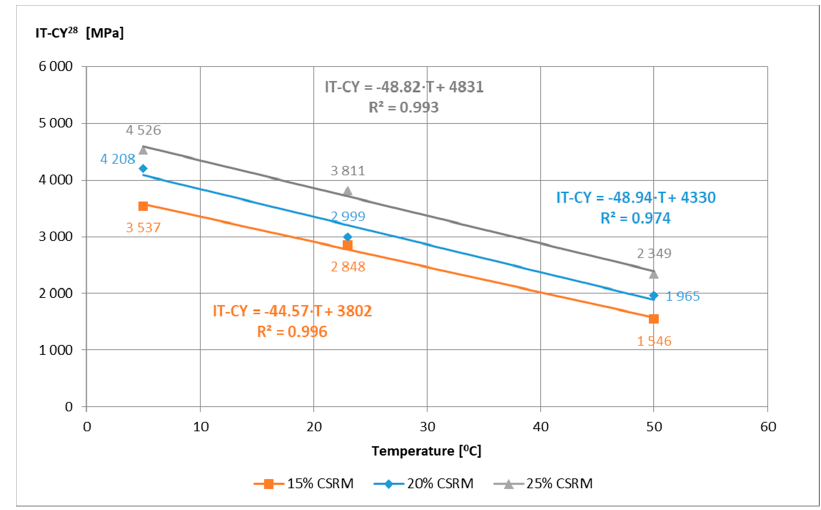
Figure 9. IT-CY stiffness modulus of ACCR with “B” CSR mortar samples Ø100 × 63.5 mm depending on the temperature, after 28 days of maturing.